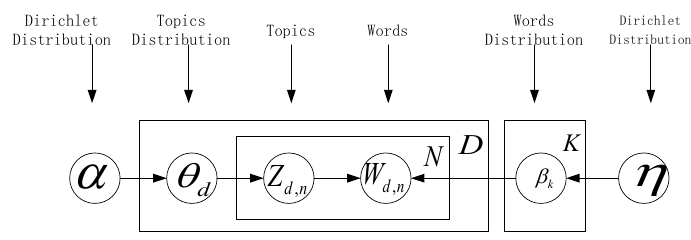
Figure 3. Probabilistic model diagram of LDA. For the input document set D = { d 1 , d 2 , . . . d i , . . . , d s } , the latent variable K